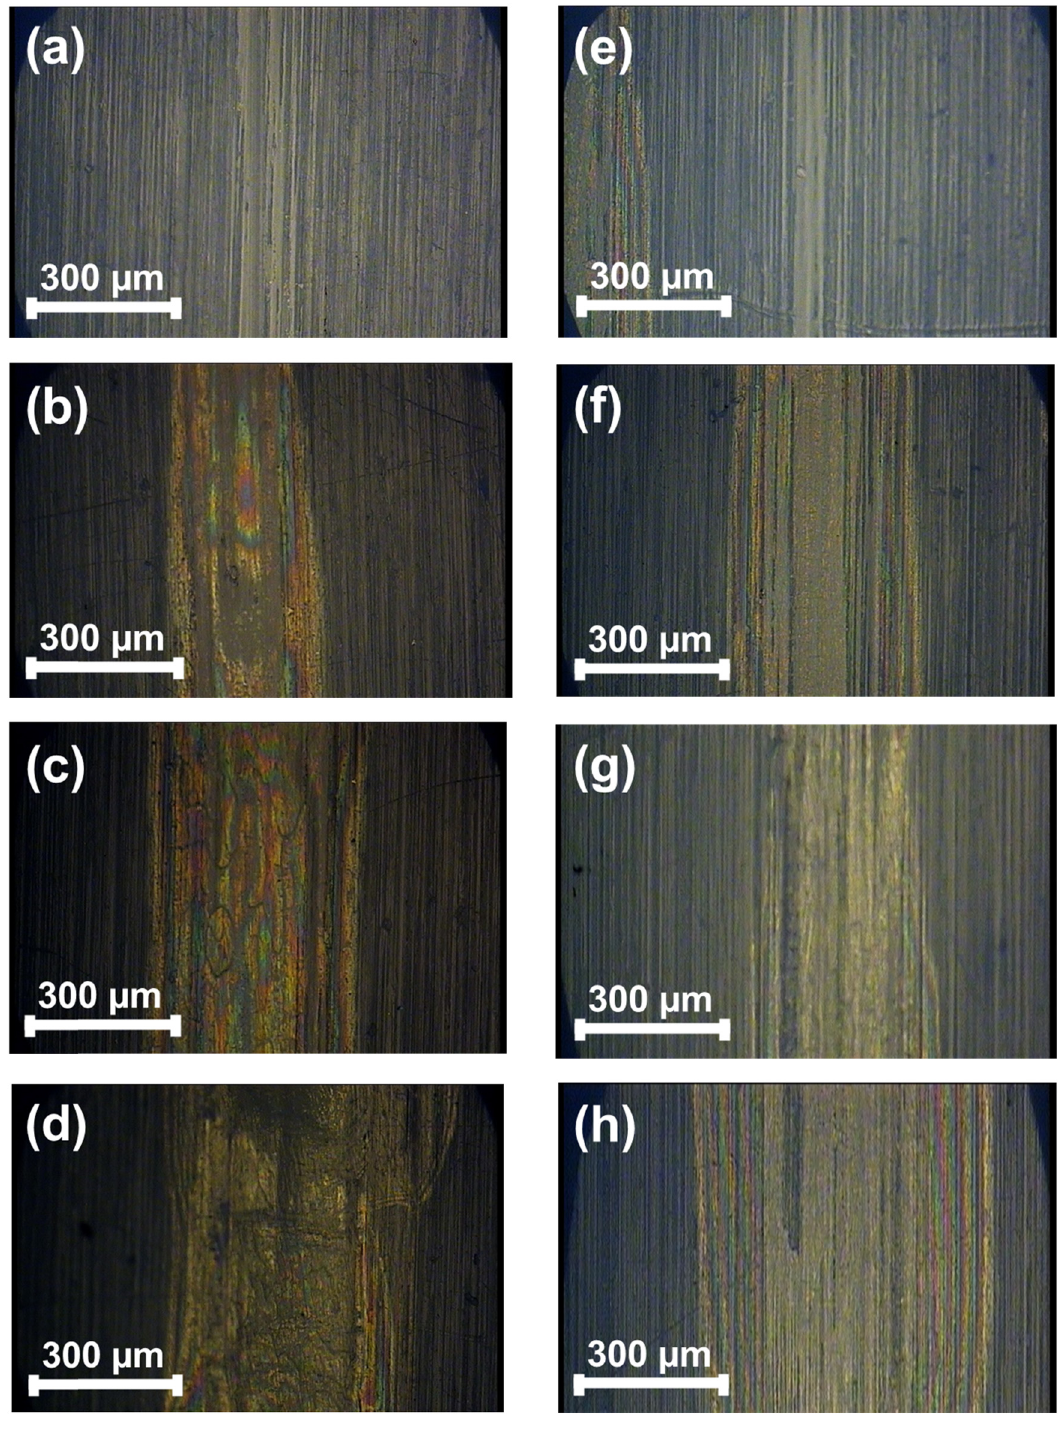
Figure 8: Optical microscopy of wear tracks produced at 1, 3, 6, and 10 N on samples made at T = 160°C ( left column: a, b, c, d ) and T = 170°C ( right column, e, f, g, h ) , respectively. Wear tracks are parallel to the textured lines of the